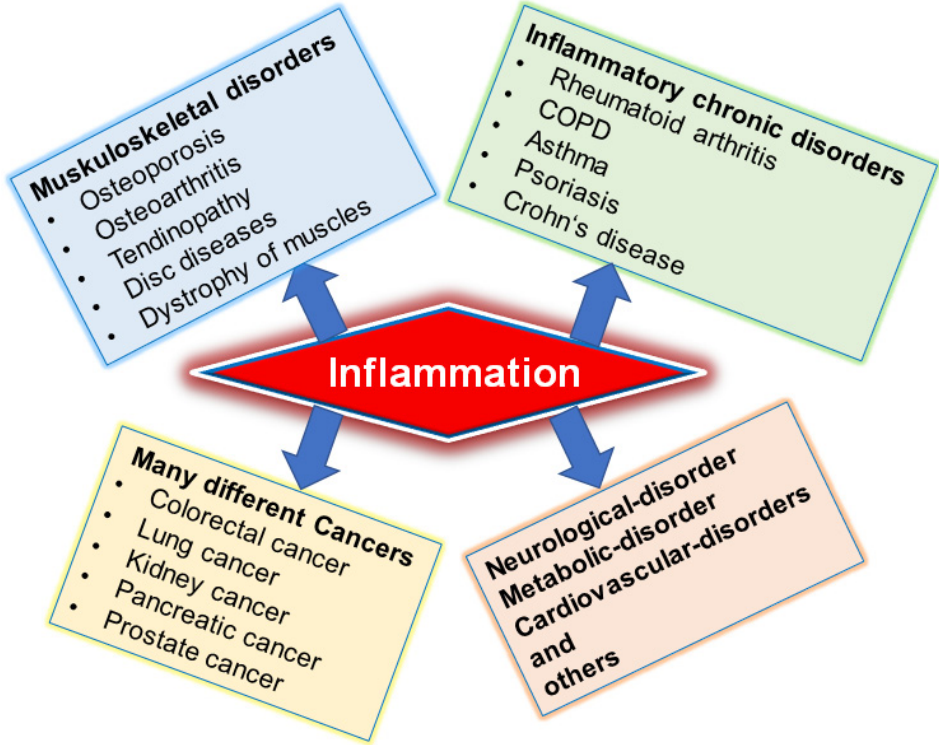
Figure 1. Inflammation in the context of different chronic disorders.